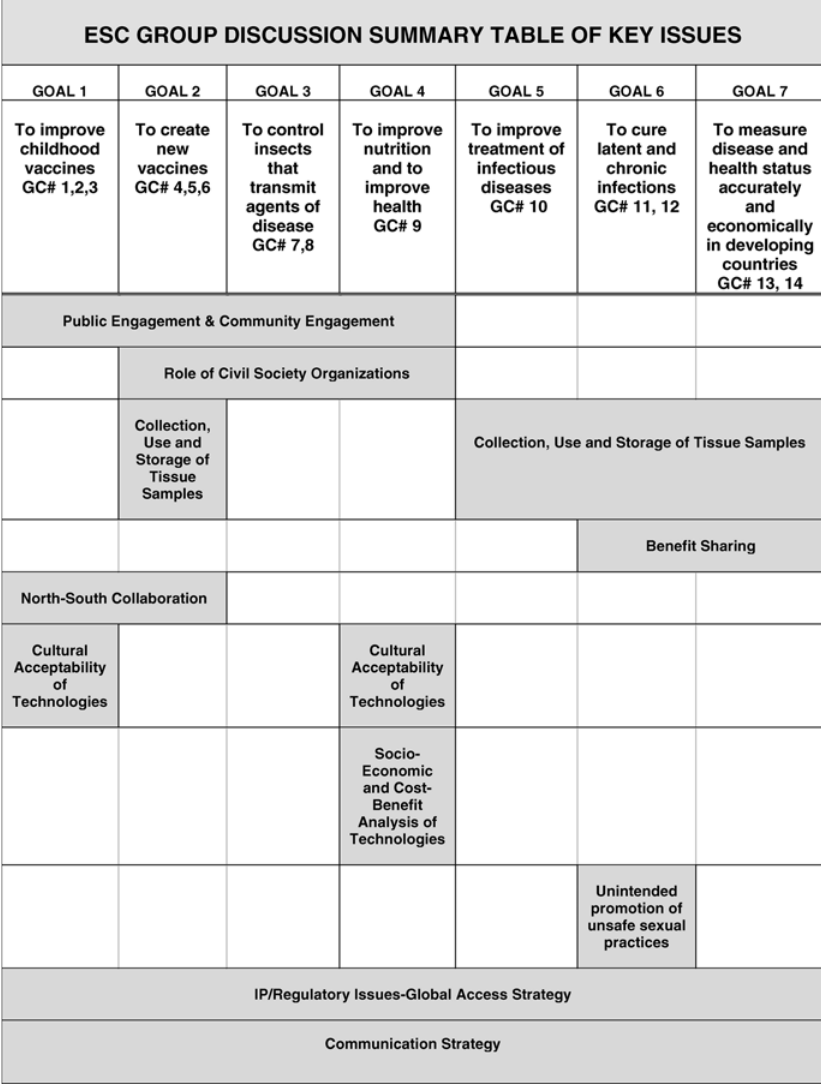
Figure 1. ESC Issues Identifi ed during Group Discussions (Seattle, Washington, November 2005) GC, Grand Challenge; IP, intellectual